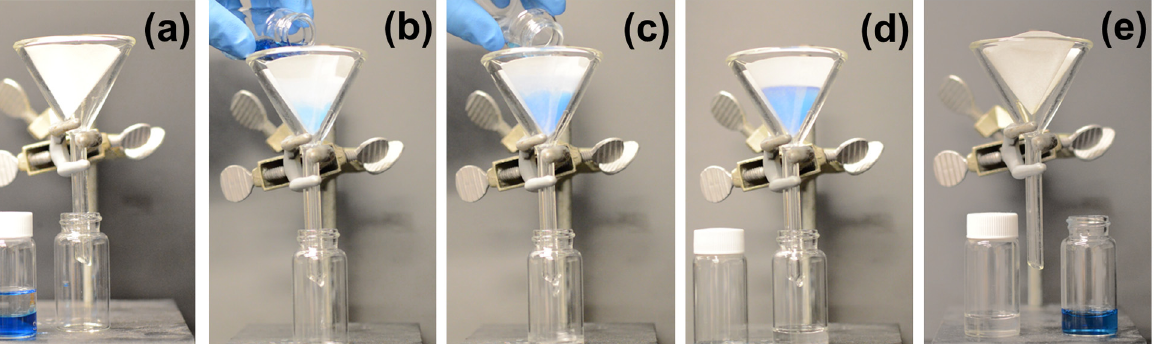
Fig 3. Separation of an oil/water mixture. The water layer has been dyed blue to allow for easier visualization. The mixture is poured onto the silanized filter paper fitted on a glass funnel. As the colorless oil layer permeates the filter paper (b-d), the water layer (blue) remains. The water layer is finally collected into a new vial and showed beside the oil sample